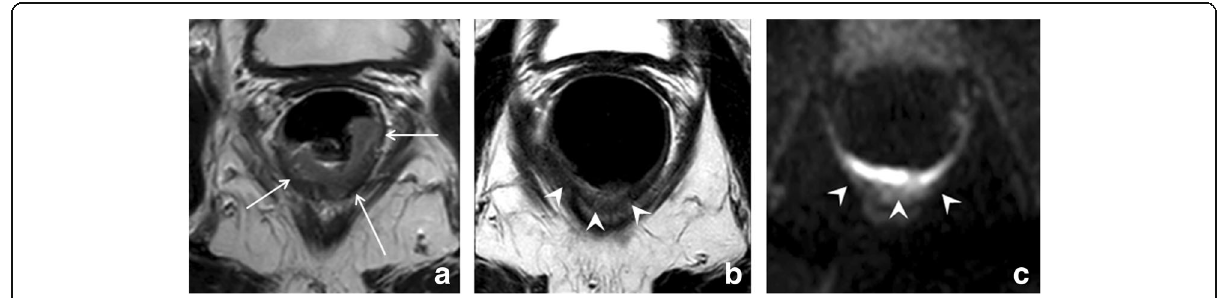
Fig. 9 Susceptibility artifacts on DWI. Pre-treatment T2-weighted MRI ( a ), post-CRT T2-weighted ( b ), and post-CRT b1000 diffusion-weighted ( c ) images of a female patient treated for a low rectal tumor (arrows in a ). On the post-CR images, a large amount of gas is present within the rectal lumen, which causes an artificial pile-up of signal projecting over the dorsal rectal wall at the site of the previous tumor bed (arrowheads in b and c ). If not recognized as an artifact, this signal may be falsely interpreted as tumor